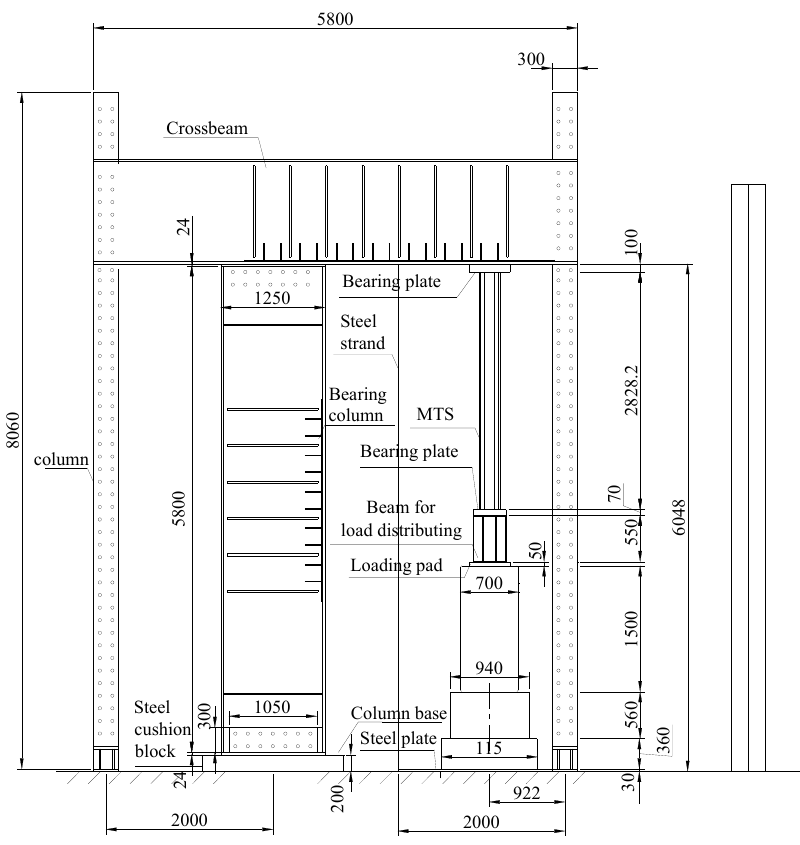
Figure 4. Elevation schematic view of the test setup (unit: mm).